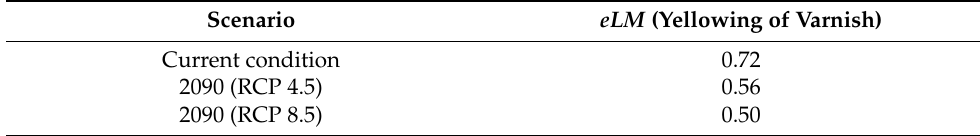
Table 7. Risk of chemical deterioration for different climate scenarios.